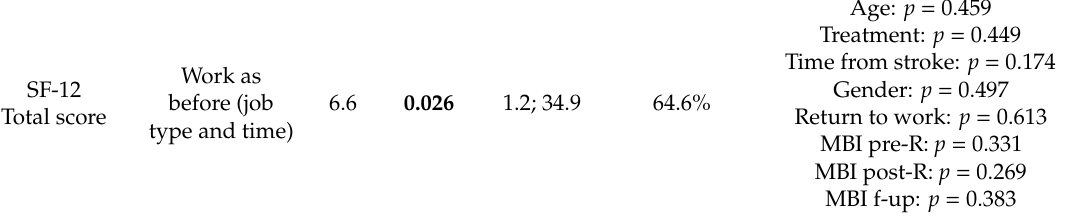
Table 3: they were more independent in the activities of daily living (MBI at follow-up), with a higher quality of life in the physical domain, and fewer needed an assistive device when compared to those